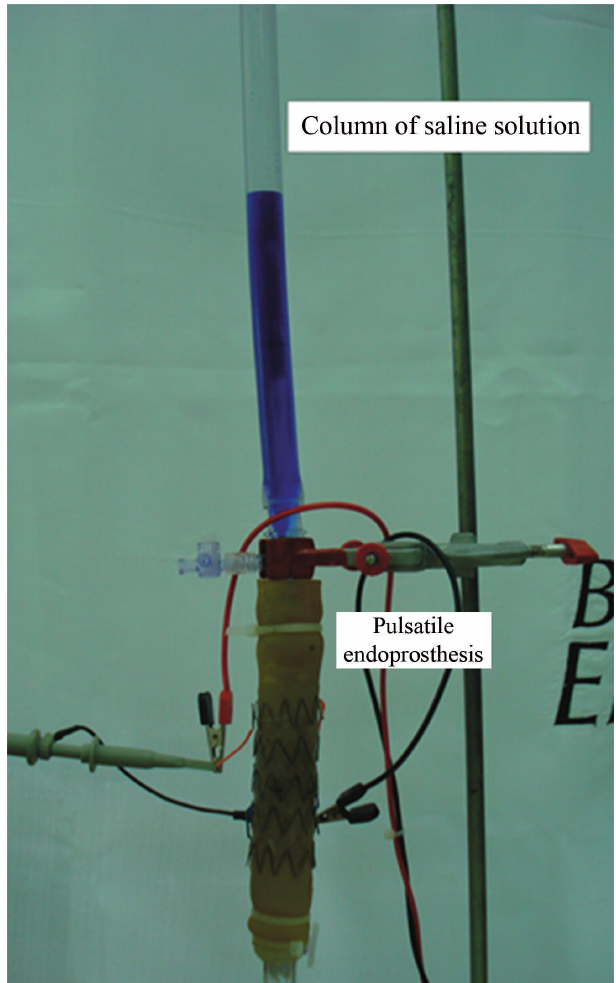
Fig. 2 - Illustration of the cycle relaxation (I) / activation (II) to which the pulsatile stent is subjected